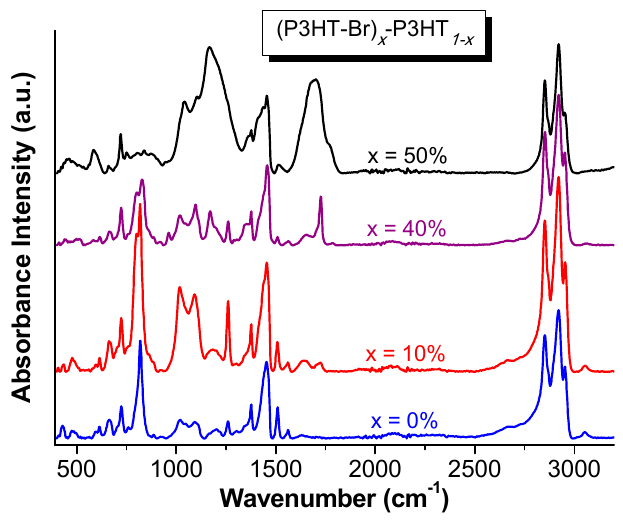
Figure 2. ATR spectra of an unfunctionalized P3HT and various ratios of side bromine-functionalized P3HTs.